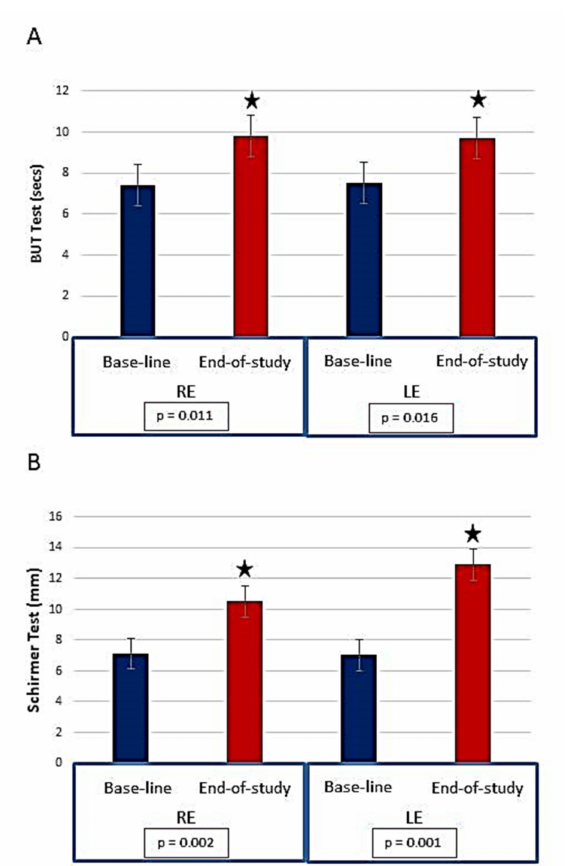
Figure 3. Clinical probes to qualitative and quantitative evaluating the tear film from baseline to the end of study in the participants randomly assigned to a daily intake of 30 g. of the fresh TN Chufa de Valencia . ( A ) Data from the FTBUT in both eyes. ( B ) Schirmer test determination in both eyes. F-BUT (cid:70) p test: Fluorescein break up time test; RE: right eye LE: left eye. < 0.05 statistically